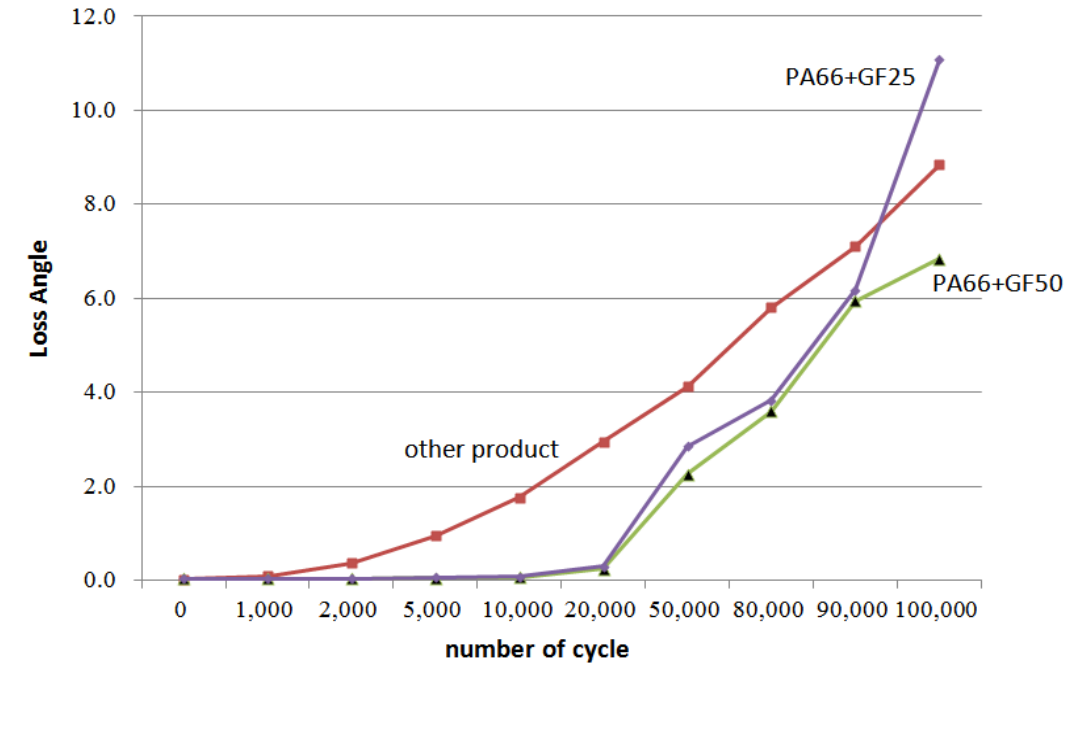
Figure 11. Variation of plastic worm wheel loss angle according to